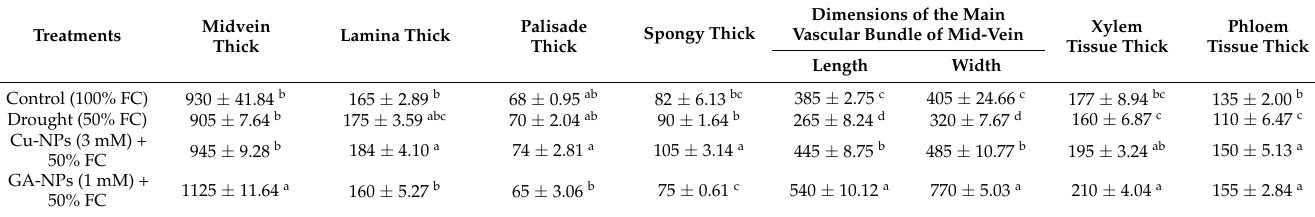
Figure 7. ( A ). The effect of Cu-NPs and GA-NPs at different concentrations on the number of T. urticae at different time points in response to normal watering treatment (100% FC), ( B ). The effect of Cu-NPs and GA-NPs at different concentrations on the number of T. urticae at different time points in response to drought treatment (50% FC). Table 2. The effect of Cu-NPs (3 mM) and GAS-NPs (1 mM) on anatomical characters of soybean leaf ( µ m) under drought stress (50%